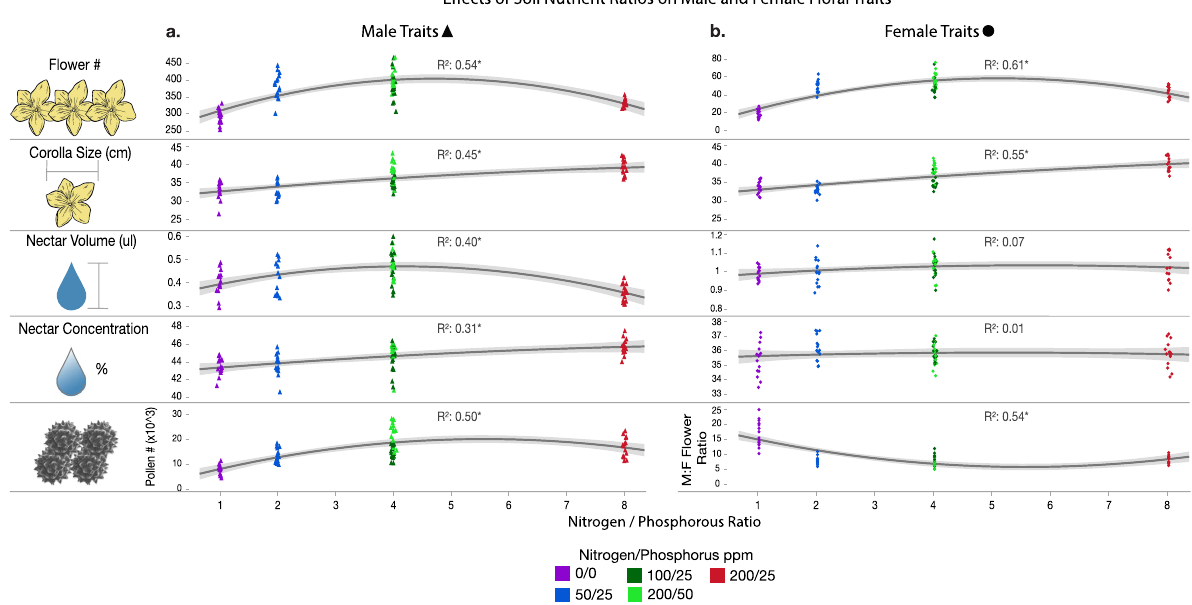
Figure 1. The effects of nitrogen:phosphorus soil nutrient ratios on floral traits (Supplementary Table S3). Regression lines are fitted with the quadratic nutrient ratio terms. Each marker represents a different individual plant, with each marker colored by their treatment group and shaped by male or female flowers. Nitrogen ppm/ phosphorus ppm of nutrient solutions for each treatment group are labeled in the legend. Note that male floral traits frequently improve as ratios increase to 4:1, yet reach asymptotic or decreased levels at 8:1. Similar effects are noticed for female traits. However neither female nectar volume nor concentration were associated